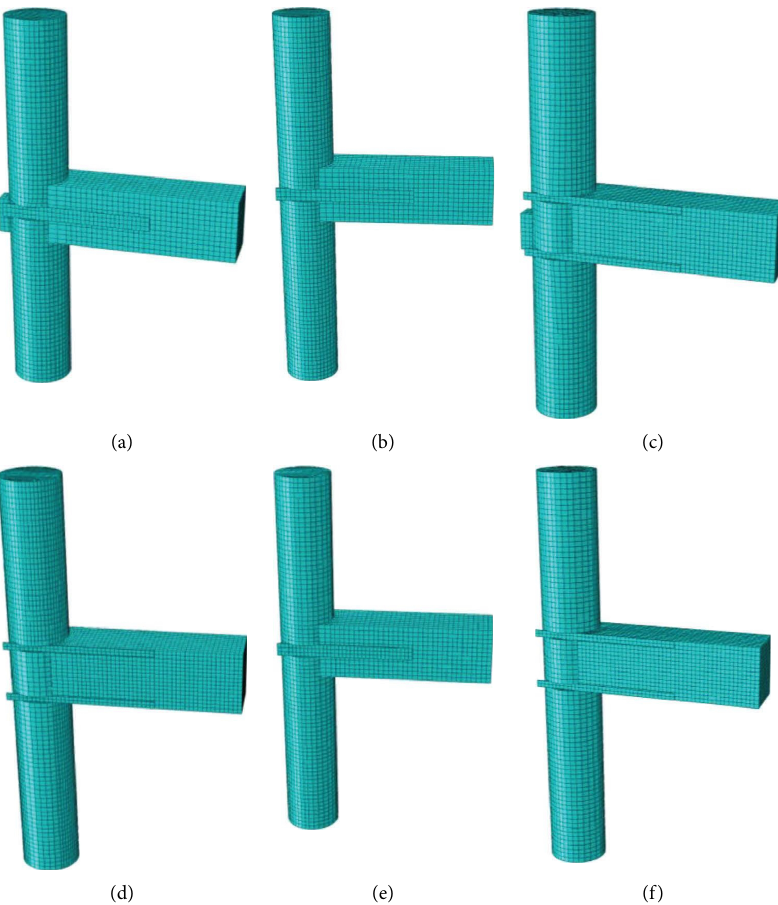
Figure 17: Finite element model of diferent steel plate reinforcement positions: (a) JD-2a model. (b) JD-2b model. (c) JD-3a model. (d) JD- 3b model. (e) JD-2c model. (f) JD-3c model.